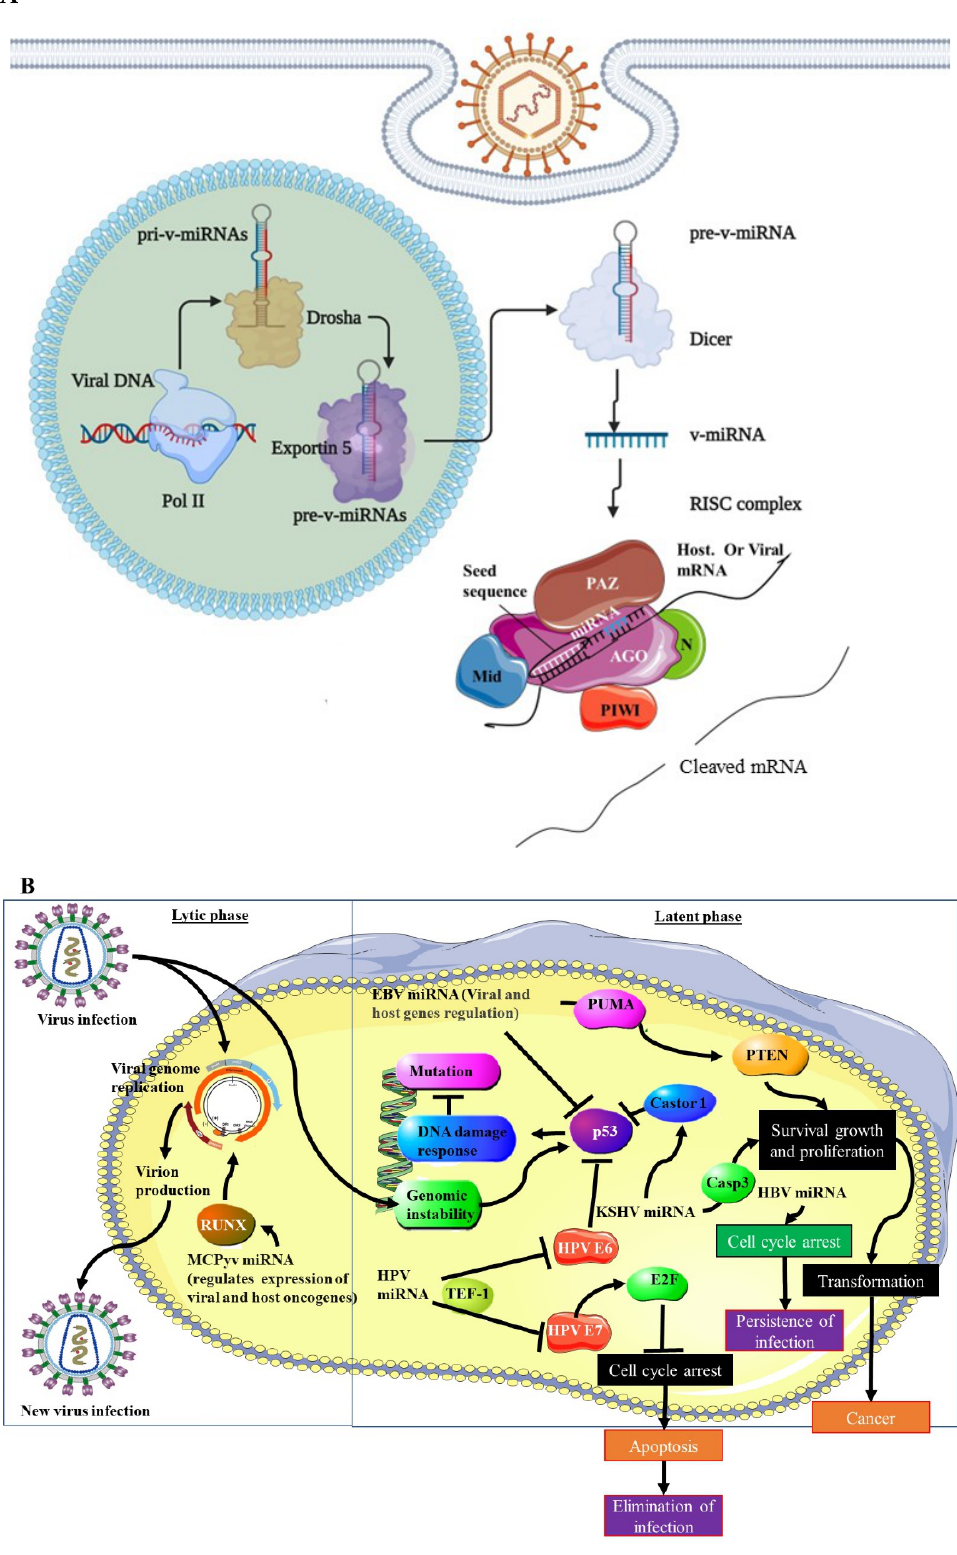
Figure 2. V-miRNAs’ mediated tumourigenesis. ( A ) Schematic representation of v-miRNA biogen- esis. Simliar to cellular miRNAs, v-miRNAs are transcribed as primary v-miRNAs (pri-v-miRNAs) in the nucleus. Pri-v-miRNAs is then cleaved by Drosha into pre-v-miRNA. Exportin 5 exports the